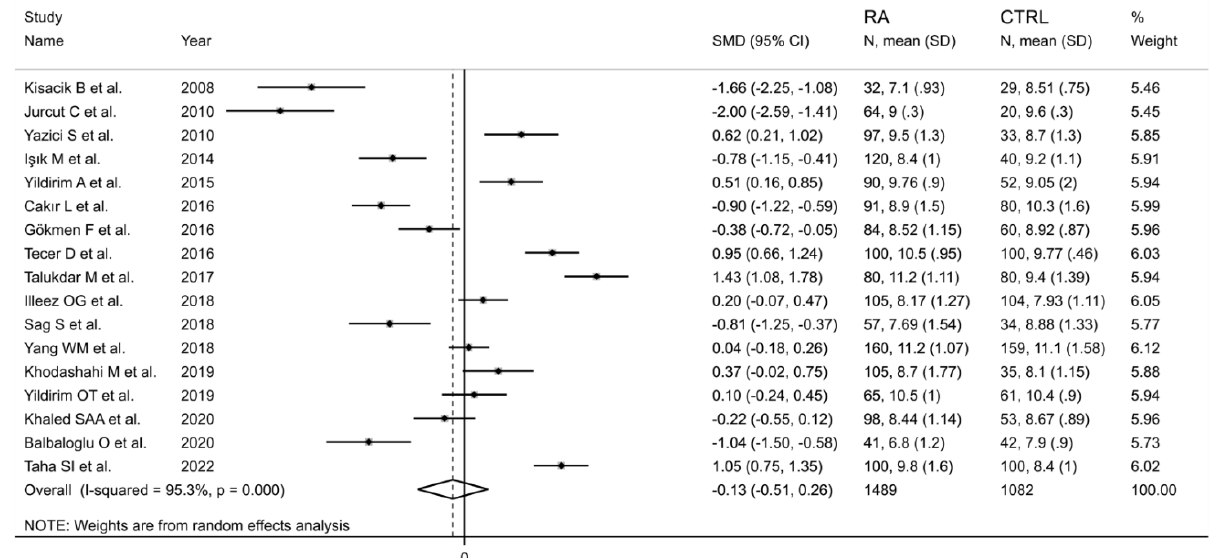
Figure 2. Forest plot of studies examining the mean platelet volume in patients with rheumatoid arthritis and healthy controls.